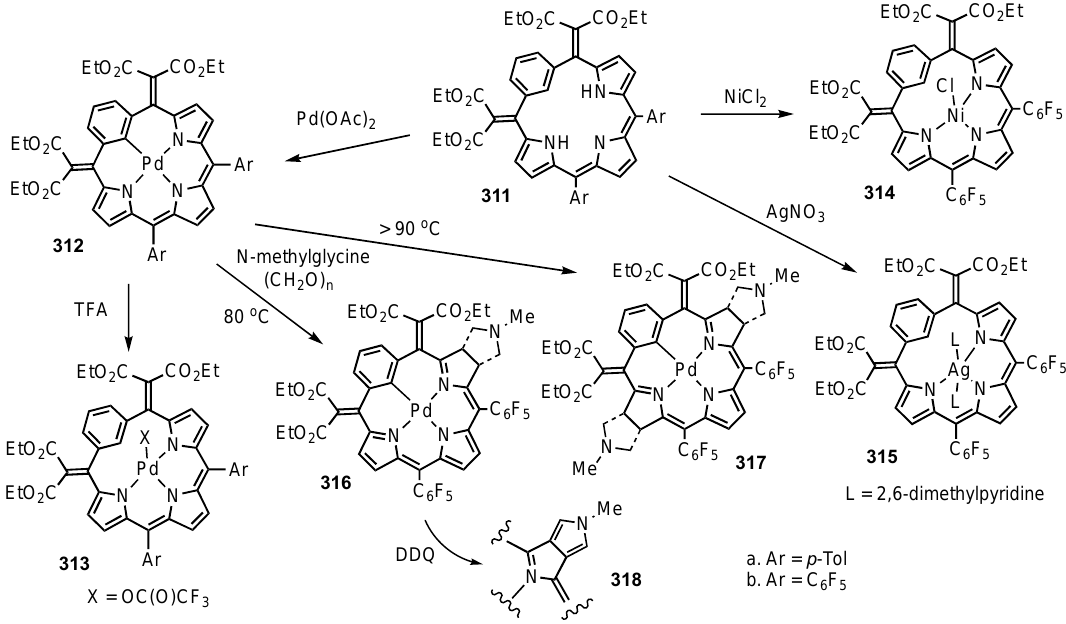
Scheme 51. Metal complexes of benziporphyrins with exocyclic double